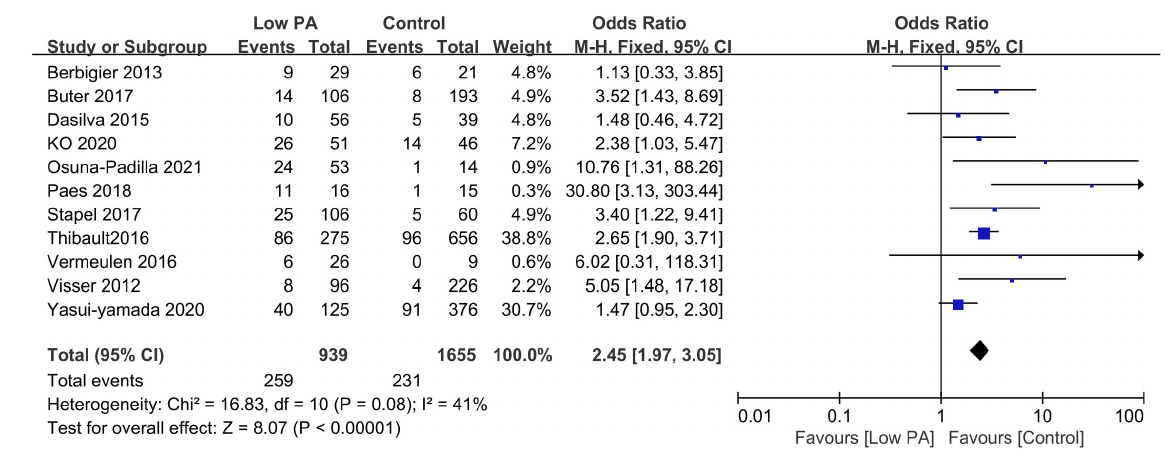
FIGURE2 Forest plot showing the mortality rate in the lower and normal phase angle groups in critically ill patients and the pooled